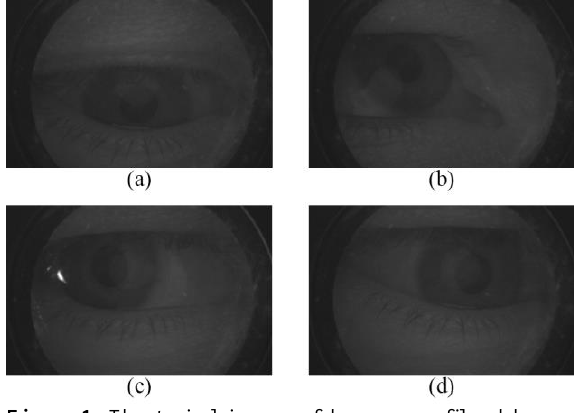
Figure 1 . The typical images of human eye filmed by used automated static perimetry